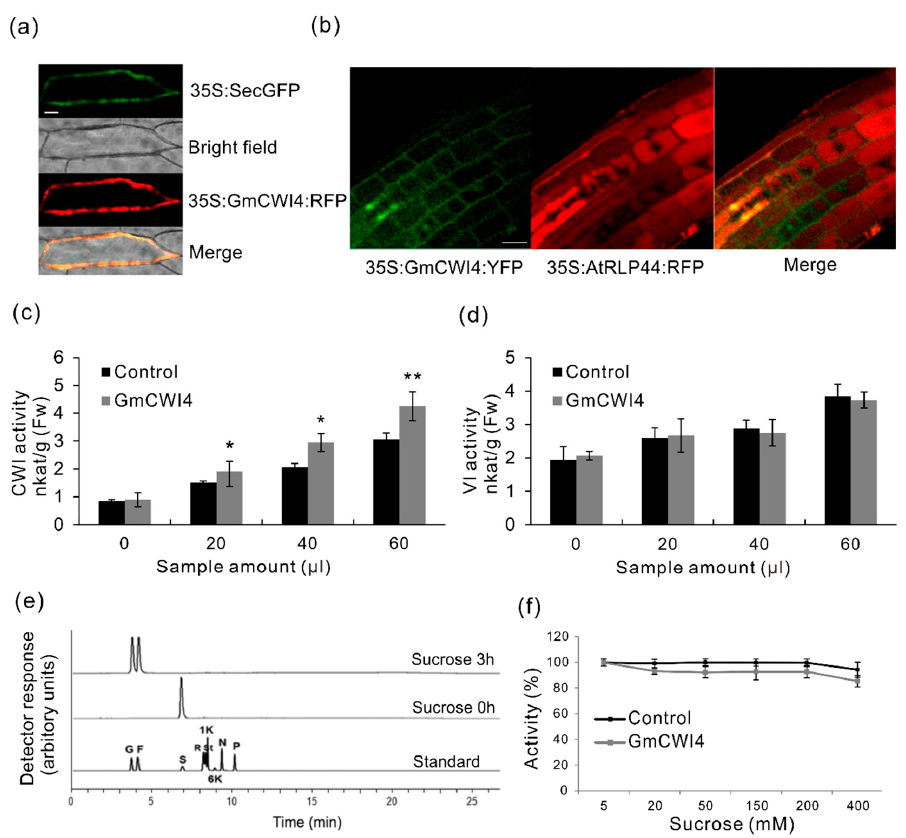
Figure 9. Detection of the subcellular localization and functional activities of GmCWI4 in vitro. Apoplastic targeting images of GmCWI4 red fluorescent protein/yellow fluorescent protein